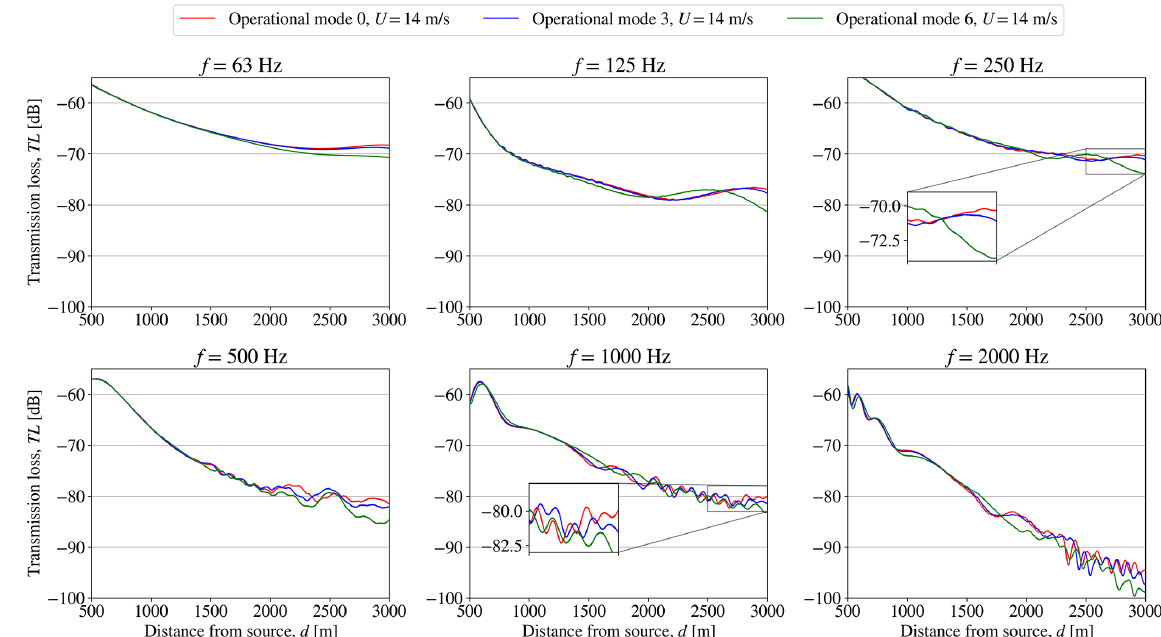
Figure A4. Setup 2: C T sensitivity of WindSTAR obtained transmission loss, TL, from a single wind turbine positioned in the wake of a wind turbine subject to changing operational modes at each octave band frequency at a free field wind speed of U 0 = 14ms − 1 .